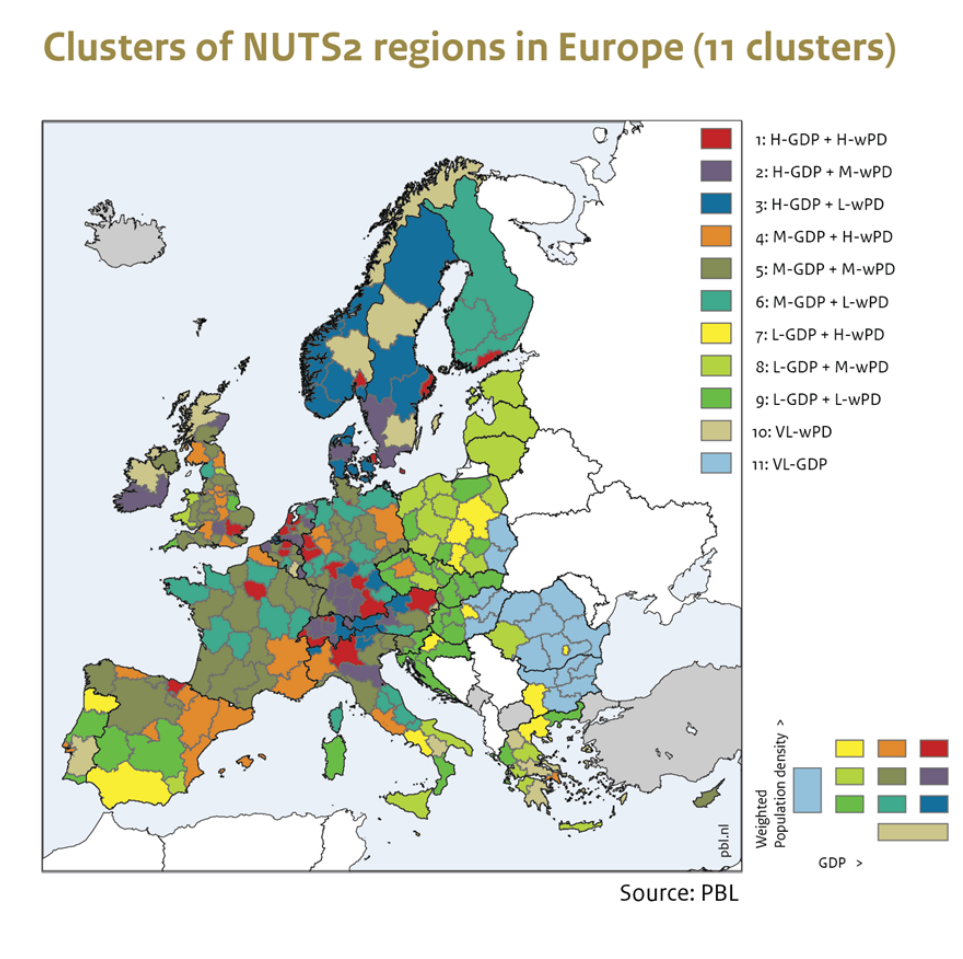
Figure A.2: Overview of the 11 different clusters in